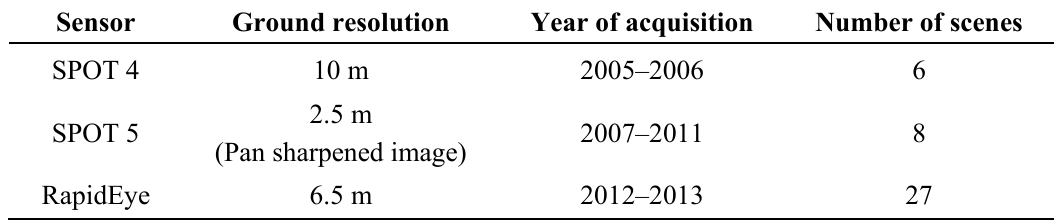
Table 1. Summary of the SPOT and RapidEye scenes used in this